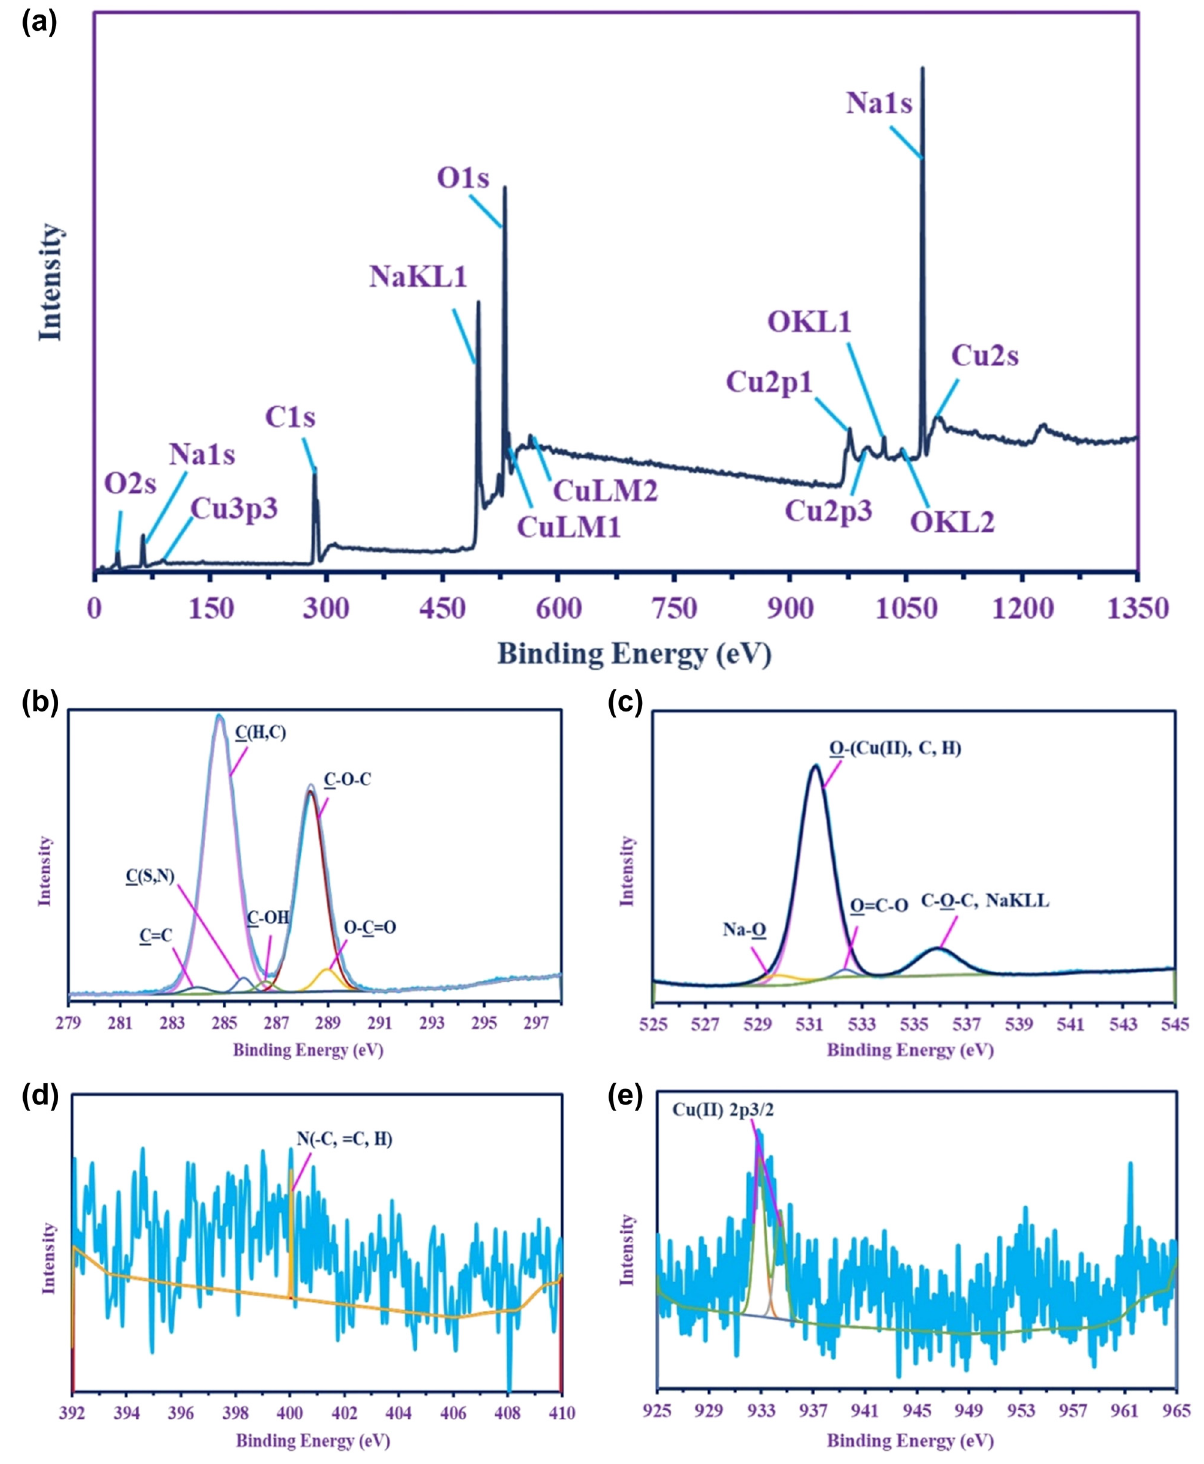
Figure 4: The XPS analysis of CuO - NPs synthesized by endophytic bacterial strain B. brevis. ( a ) XPS survey, ( b – e ) C 1s, O 1s, N 1s, and Cu2p,